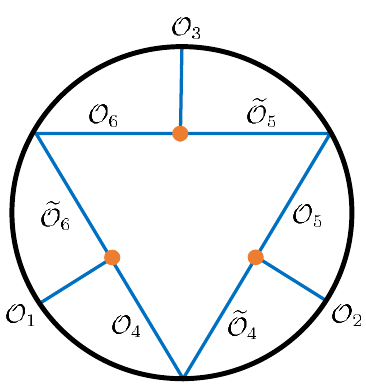
Figure 8. The AdS harmonic three-point triangle, A 1 (cid:0) loop internal lines. Boundary vertices arising from the split representation are also integrated